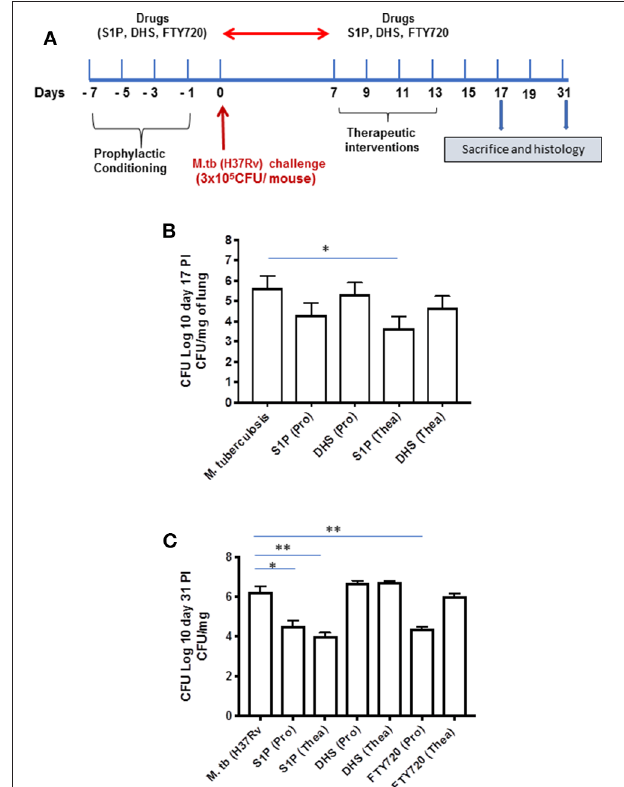
FIGURE 3 | Sphingosine-1-phosphate (S-1P) controls M. tuberculosis burden and promotes Th1 effector immune response in infected macrophages. (A) Schematic representation of aerosol experiment detailing treatment schedules with respect to the M. tuberculosis challenge. (B,C) Mice from indicated groups were sacrificed on 17th and 31st postinfection day. Lung and spleen tissues were excised, and the number of bacteria was analyzed by plate-based method. Bacterial growth was monitored at 17th (B) and 31st (C) day postinfection in lung homogenates of mice infected with M. tuberculosis (H37Rv). Shown here is CFU ± SEM from three independent experiments. Statistical analysis were conducted using two way Anova followed